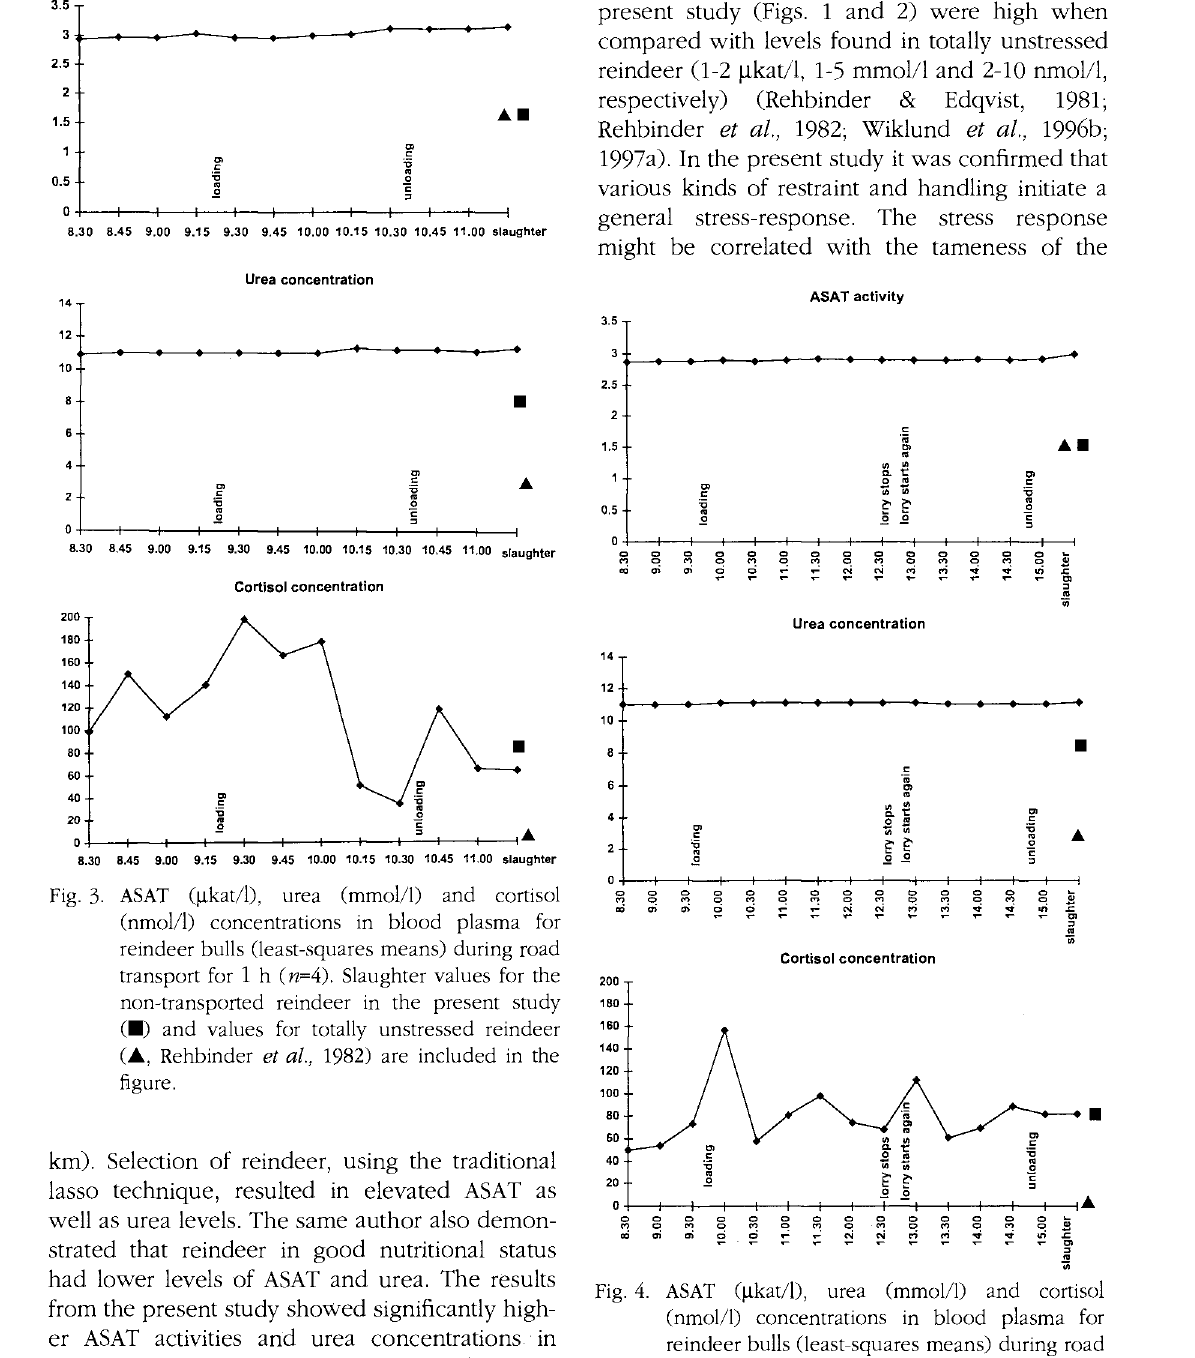
Fig. 4. ASAT (u.kat/1), urea (mmol/l) and Cortisol (nmol/l) concentrations in blood plasma for reindeer bulls (least-squares means) during road transport for 5 h (n=4). Slaughter values for the non-transported reindeer in the present study (•) and values for totally unstressed reindeer (A, Rehbinder et al., 1982) are included in the